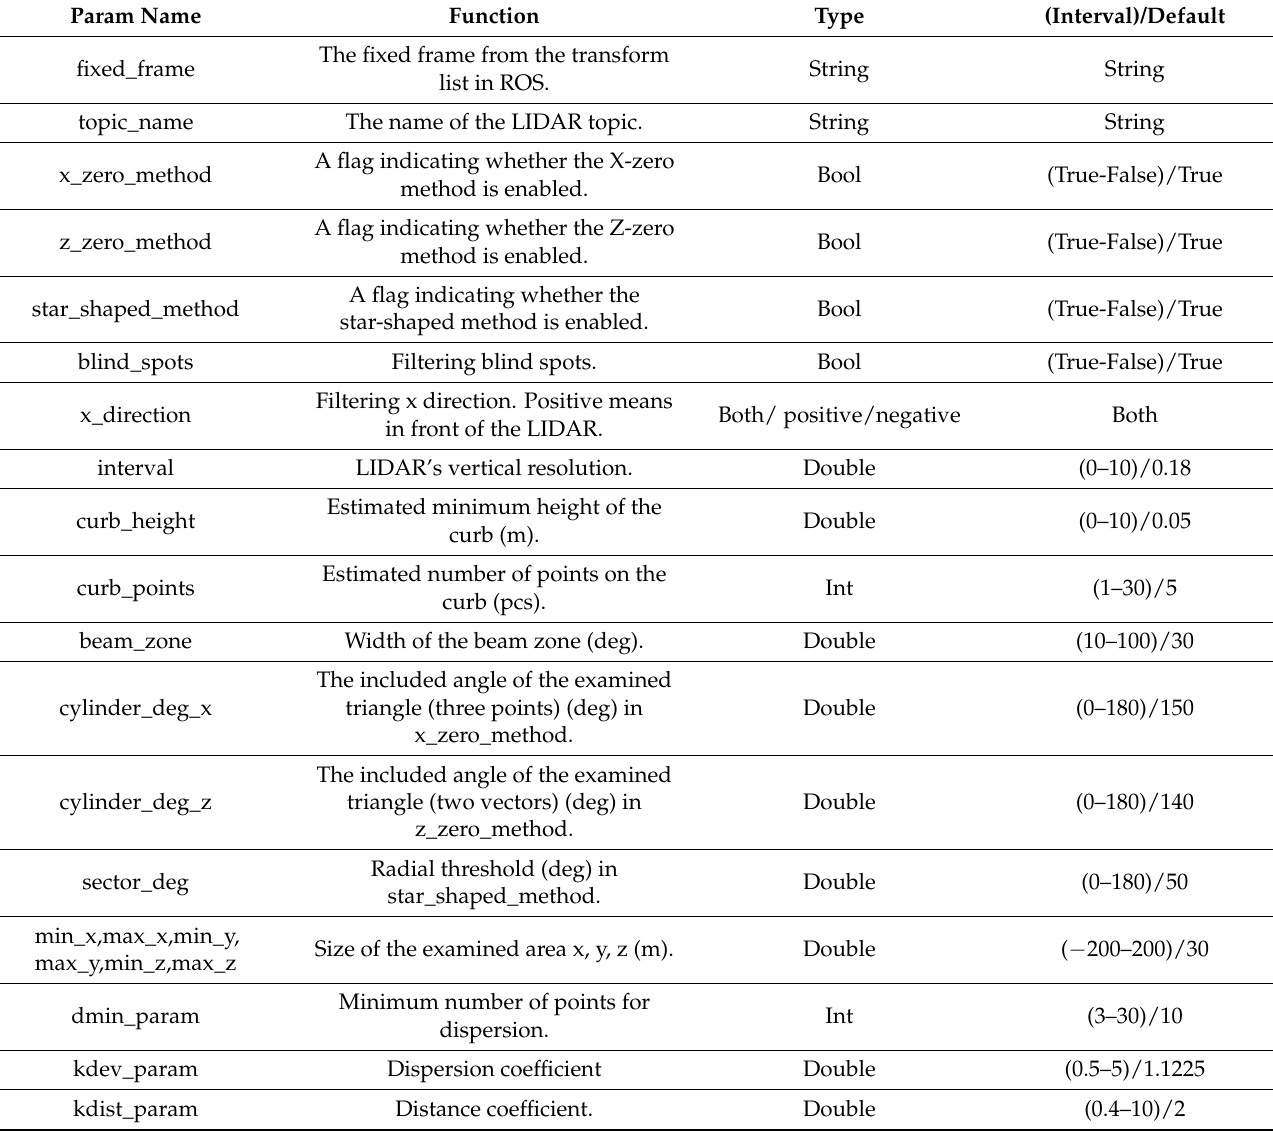
Table 1. The parameter list of the urban road